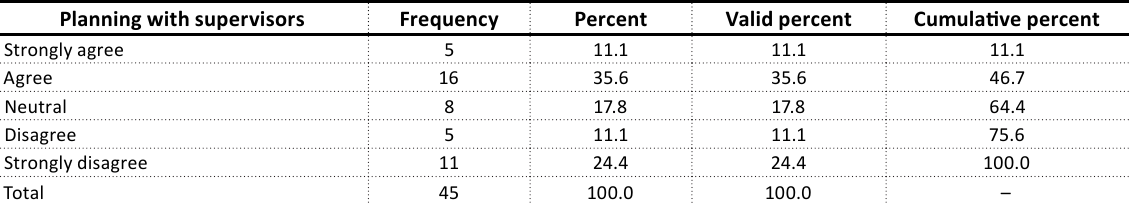
Table 11. Frequency showing the planning with supervisors Planning with supervisors